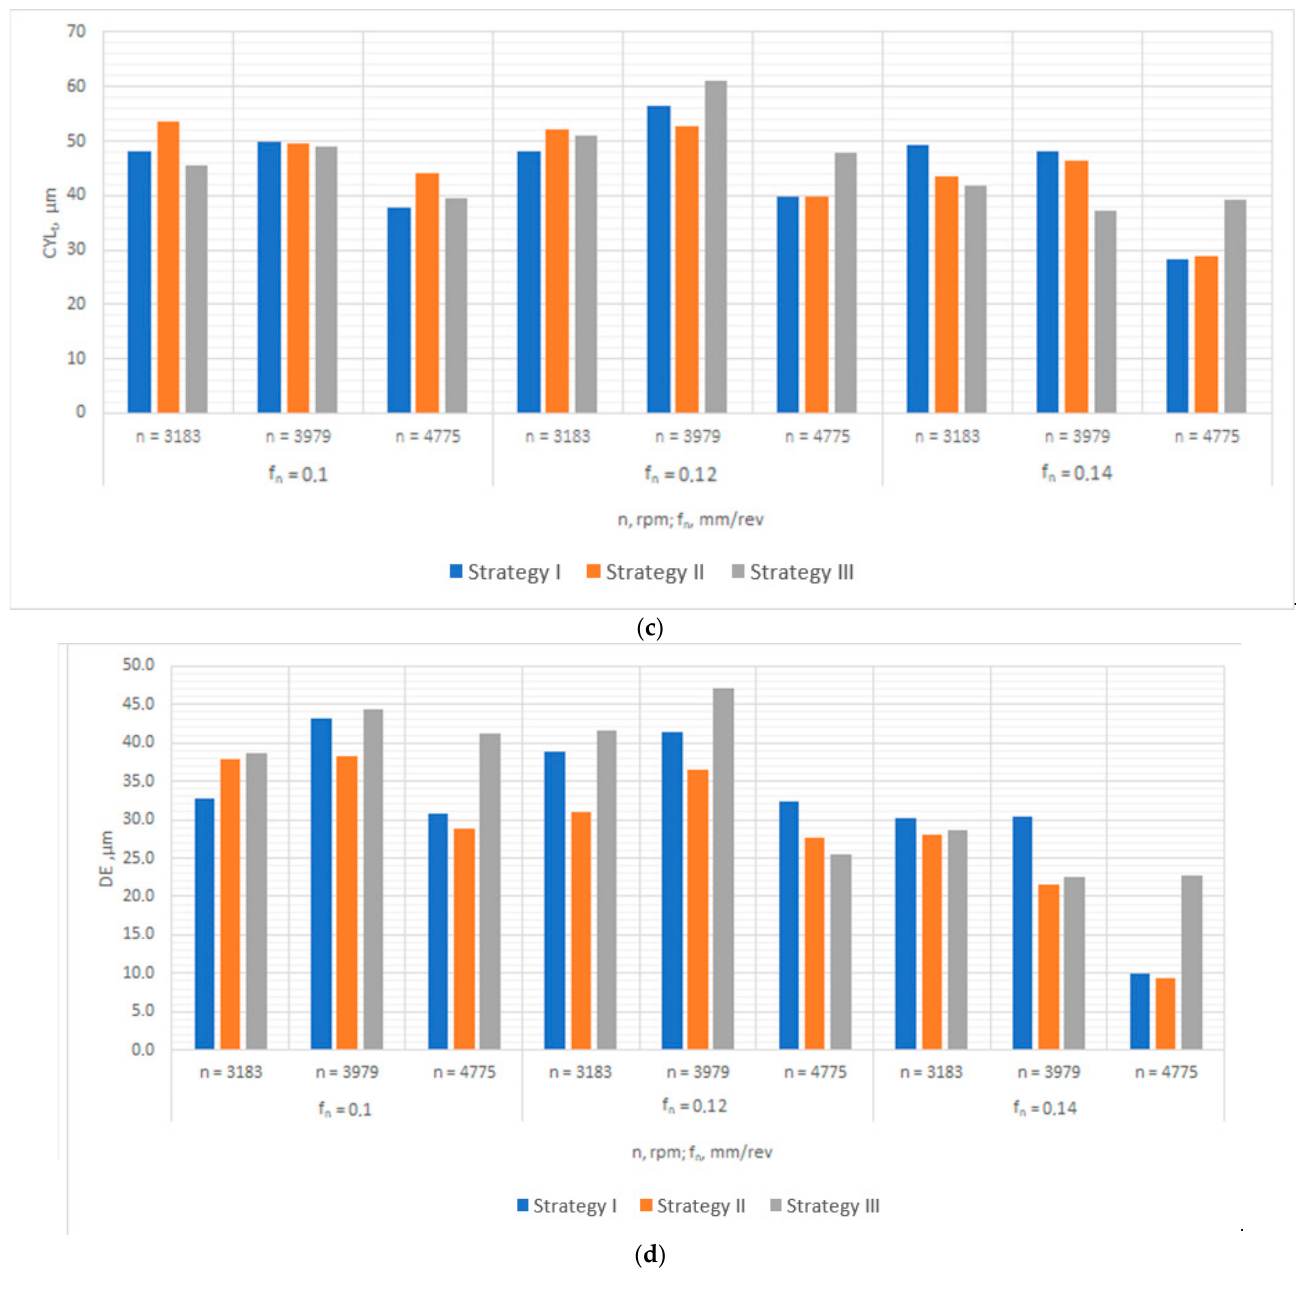
Figure 4. Graphical representation of the measured data: ( a ) straightness error, ( b ) roundness error, ( c ) cylindricity error, ( d ) diameter error.